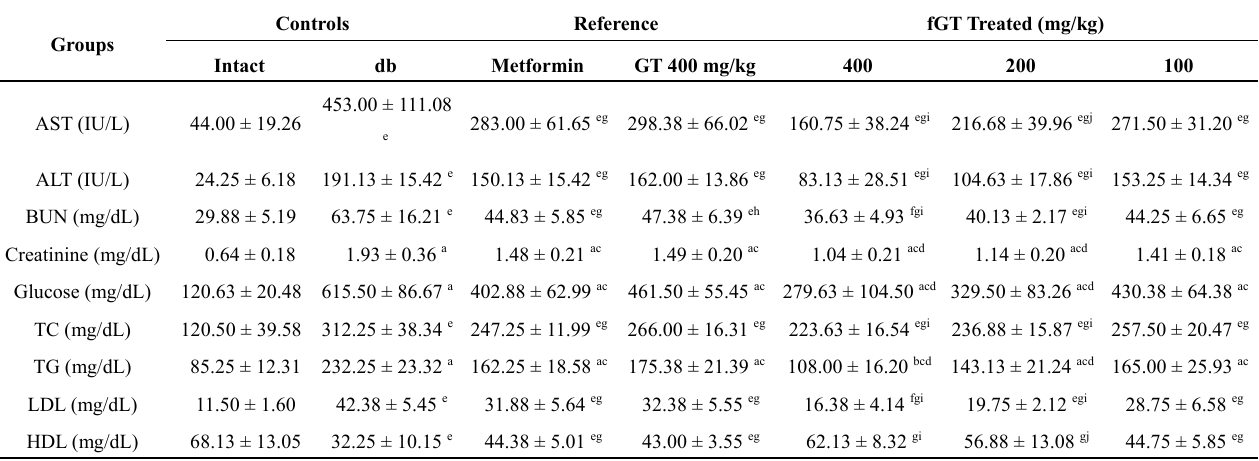
Table 8. Changes on serum biochemistry in intact normoglycemic and db/db